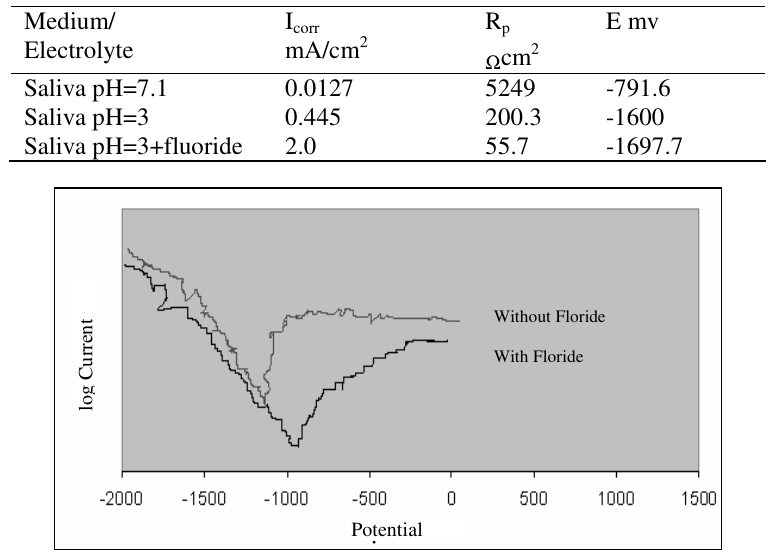
Table 1 . Summary of electrochemical parameters for titanium in different media.